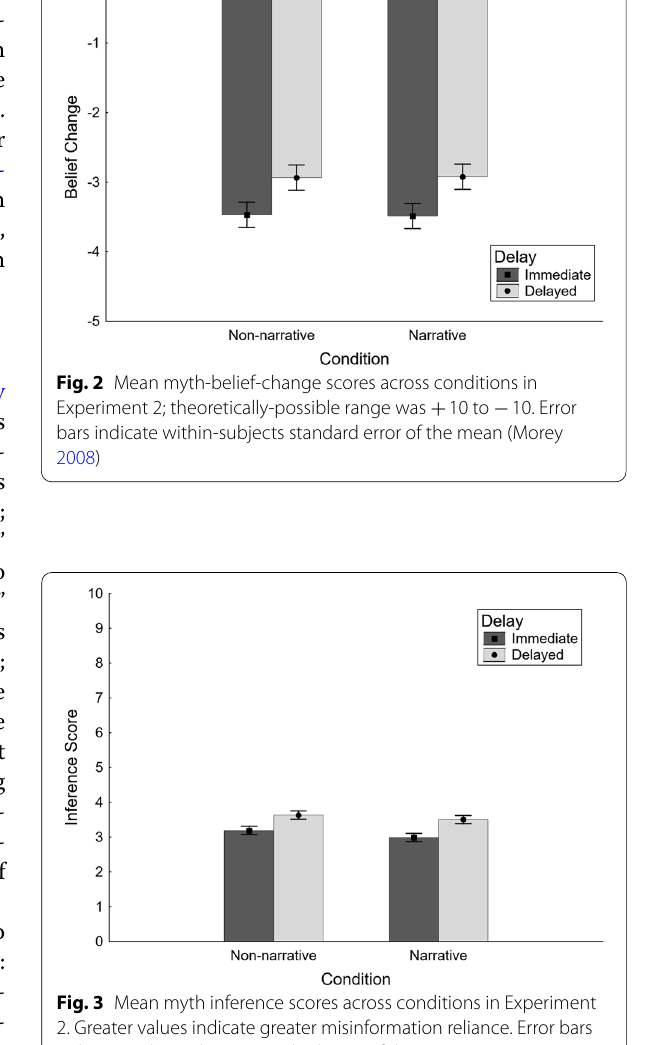
Fig. 3 Mean myth inference scores across conditions in Experiment 2. Greater values indicate greater misinformation reliance. Error bars indicate within-subjects standard error of the mean (Morey